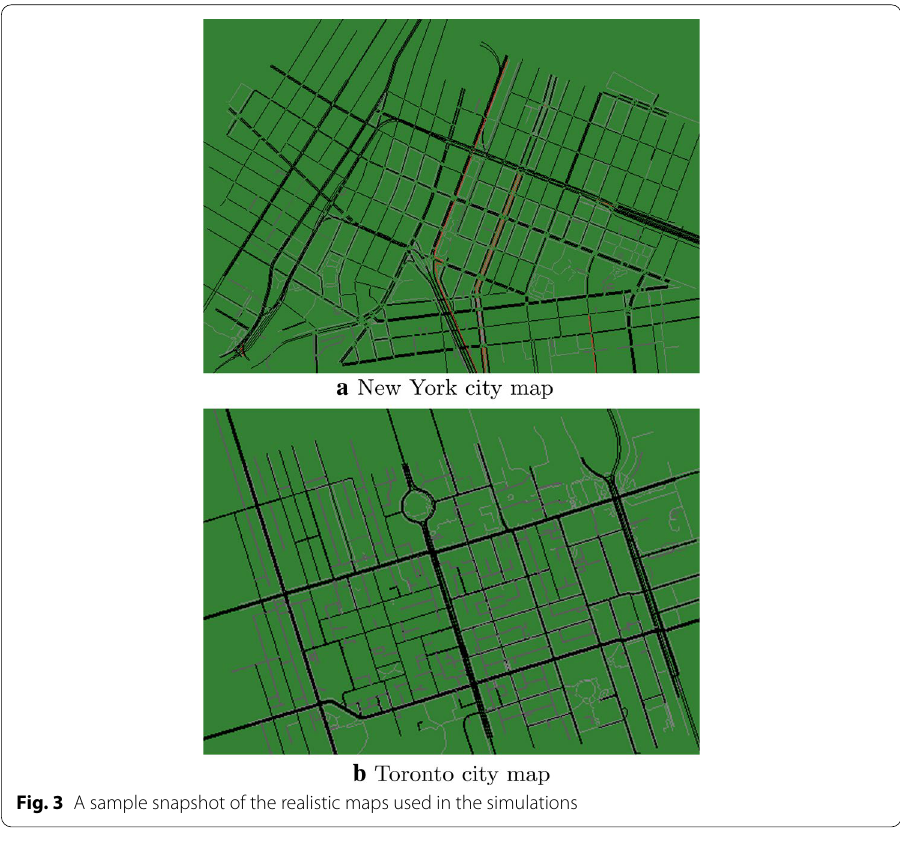
Fig. 3 A sample snapshot of the realistic maps used in the simulations